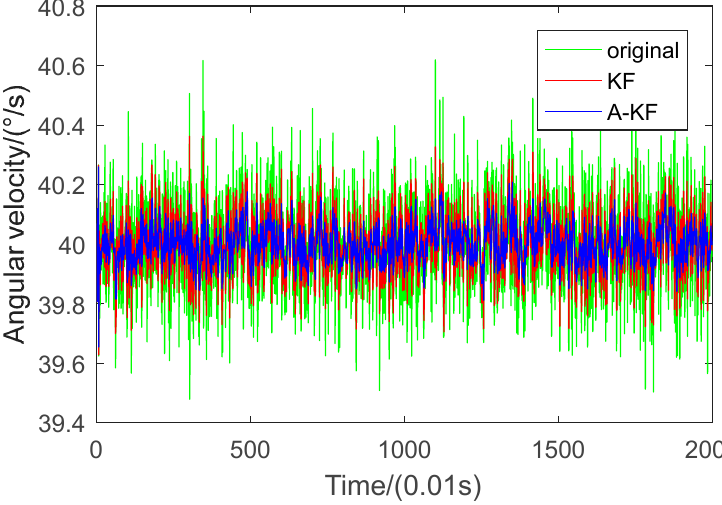
Figure 5. Comparison of filtering results.